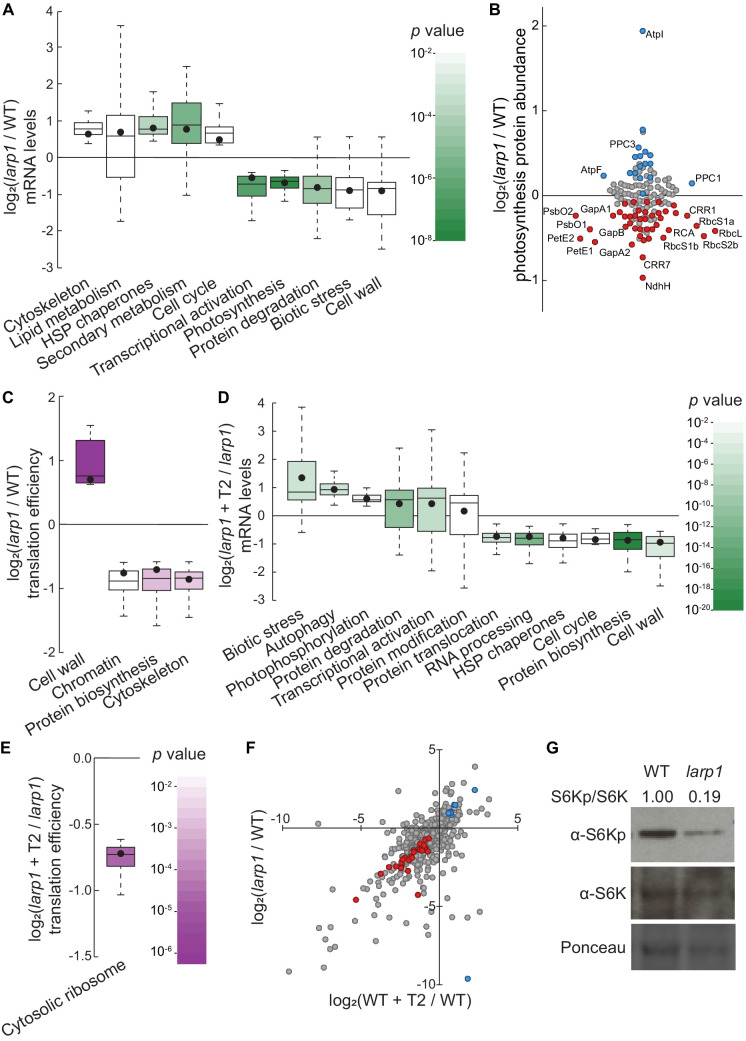
LARP1 promotes TOR signaling and activity in growing Arabidopsis seedlings.(A) Multiple categories of transcripts accumulated to significantly different levels in larp1 compared to wild-type. Most significantly, photosynthesis-associated nuclear gene expression was strongly repressed in larp1 mutants. Here and below, the observed fold-change in mRNA levels for each category is shown in box-whisker plots drawn with Tukey’s method; the middle line represents the median and the dot represents the mean of the fold-changes. p values for each category were determined by the Mann–Whitney U test using MapMan gene ontologies and corrected for false positives with the stringent Benjamini-Yekutieli method. (B) Correlating with lower chlorophyll levels (Figure 3G), global quantitative proteomics revealed that most photosynthesis-related protein levels were lower in larp1 mutants. The color-coded dots represent proteins that were detected at significantly higher (blue) or lower (red) levels in larp1 compared to WT, with representative proteins labeled. (C) Many transcripts show differences in TE in larp1 compared to wild-type, as depicted in box-whisker plots (drawn as in A) showing significantly-affected MapMan categories with p values colored as in panel E. (D) Torin2 treatment in the larp1 background affects the mRNA levels of multiple functional categories, mostly similar to the effects of Torin2 on mRNA levels in wild-type plants (Figure 1C), including repression of protein biosynthesis, cell-cycle progression, and protein sorting, alongside induction of stress responses and protein degradation pathways. (E) The TE of cytosolic ribosomal mRNAs is significantly repressed by Torin2 treatment in larp1 mutants. (F) TOR activity is reduced in larp1 mutants. Observed differences in phosphoprotein abundance in mock-treated larp1 compared to wild-type (y axis) are mapped against Torin2-treated WT versus to mock-treated WT (x axis); phosphoproteins that accumulated to significantly different levels (p<0.05) in both comparisons are highlighted in red and blue. The strong positive correlation shown suggests that the TOR signaling network is relatively inactive in larp1 mutants than in WT. (G) Phosphorylation of the direct TOR substrate, S6K-pT449, is drastically reduced in larp1 mutants compared to WT, confirming the results shown in panel F. The densitometry ratio between the levels of S6K-pT449 and total S6K are shown above. This experiment was repeated three times with consistent results.